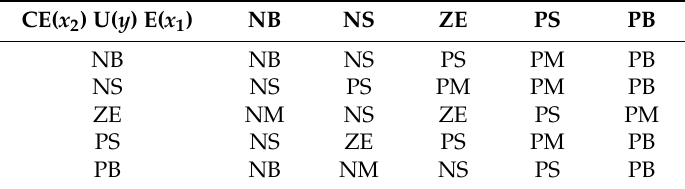
Table 2. The input and output variables and initial